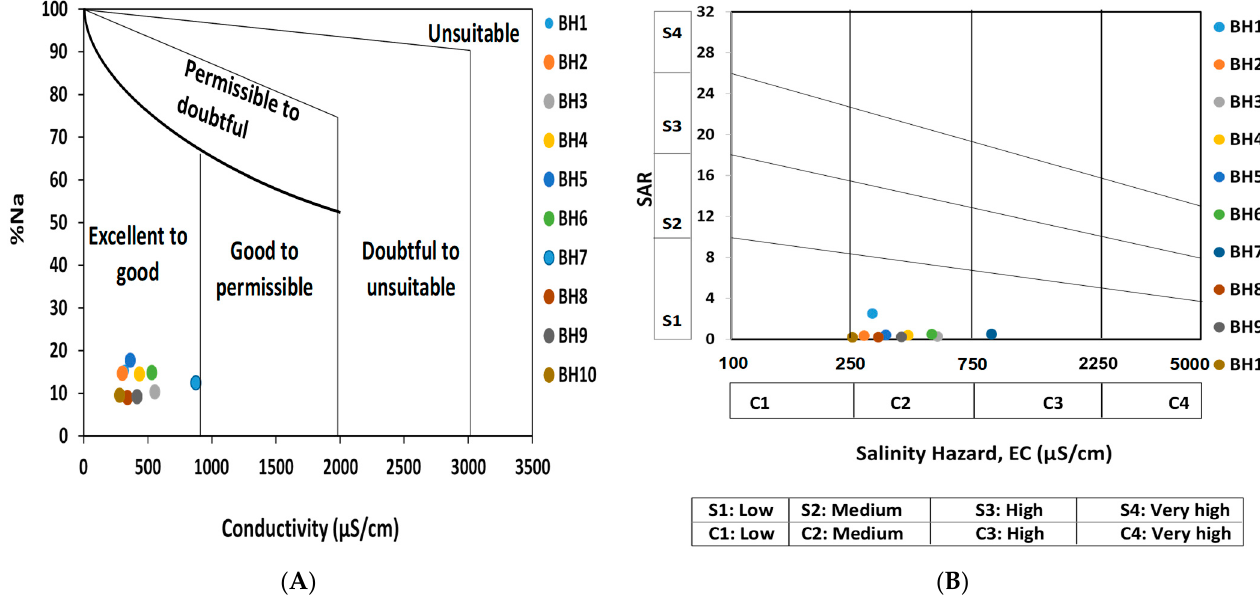
Figure 10. Suitability of the groundwater for irrigation based on ( A ) a United States Salinity Labor- atory Staff diagram and ( B ) Wilcox salinity